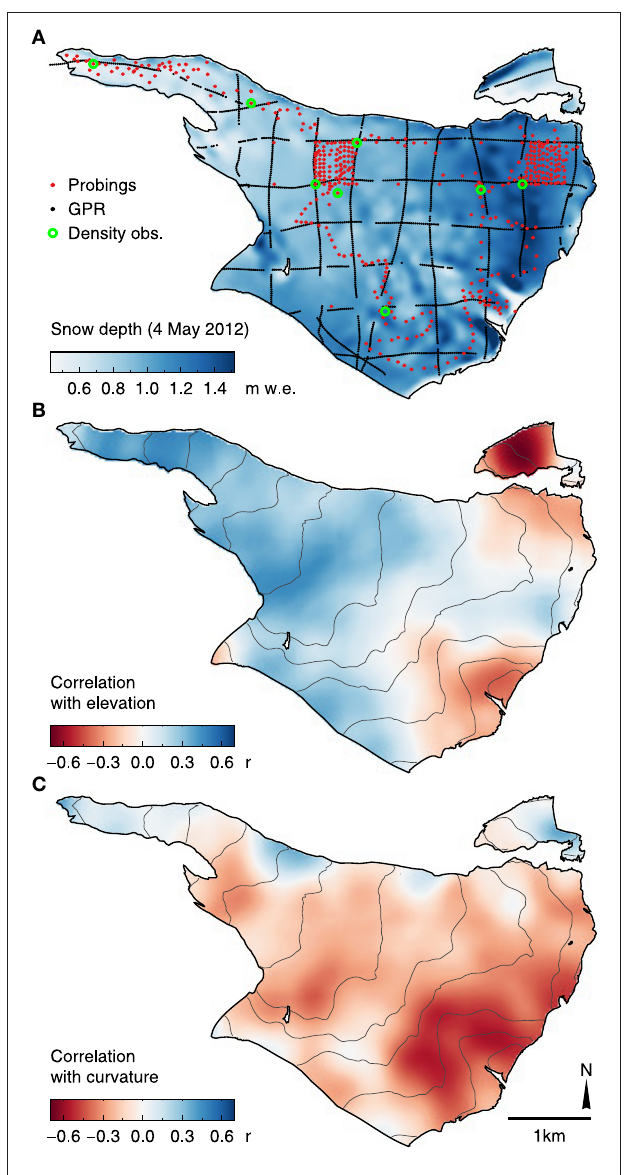
FIGURE 8 | (A) Snow accumulation distribution on 4 May 2012 derived from the GPR measurements by GWR interpolation. Correlations of snow depth with (B) elevation and (C) curvature ( 125m scale). Gray lines in (B,C) are 100m elevation contours.